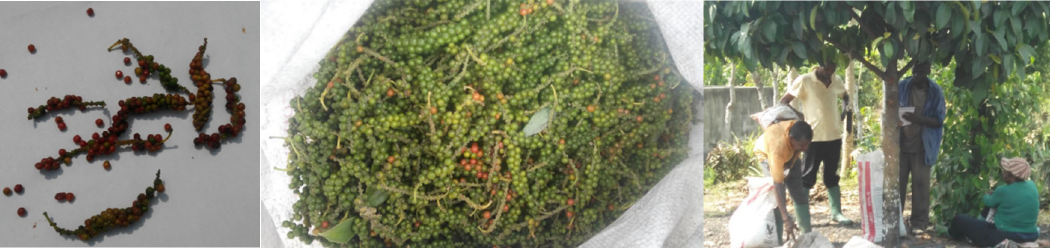
Figure 5. Mature green and red pepper collected in reused plastic bags (Njombe, Cameroon).